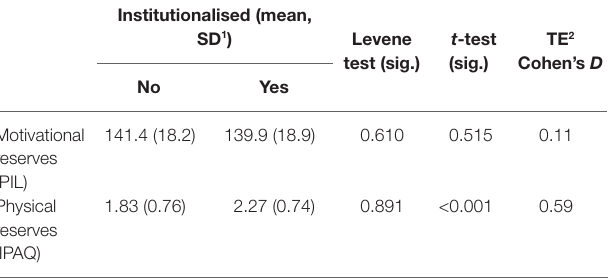
TABLE 3 | Differences according to life context (institutionalised or not) on physical and motivational reserves. Institutionalised (mean, SD 1 ) Levene test (sig.)